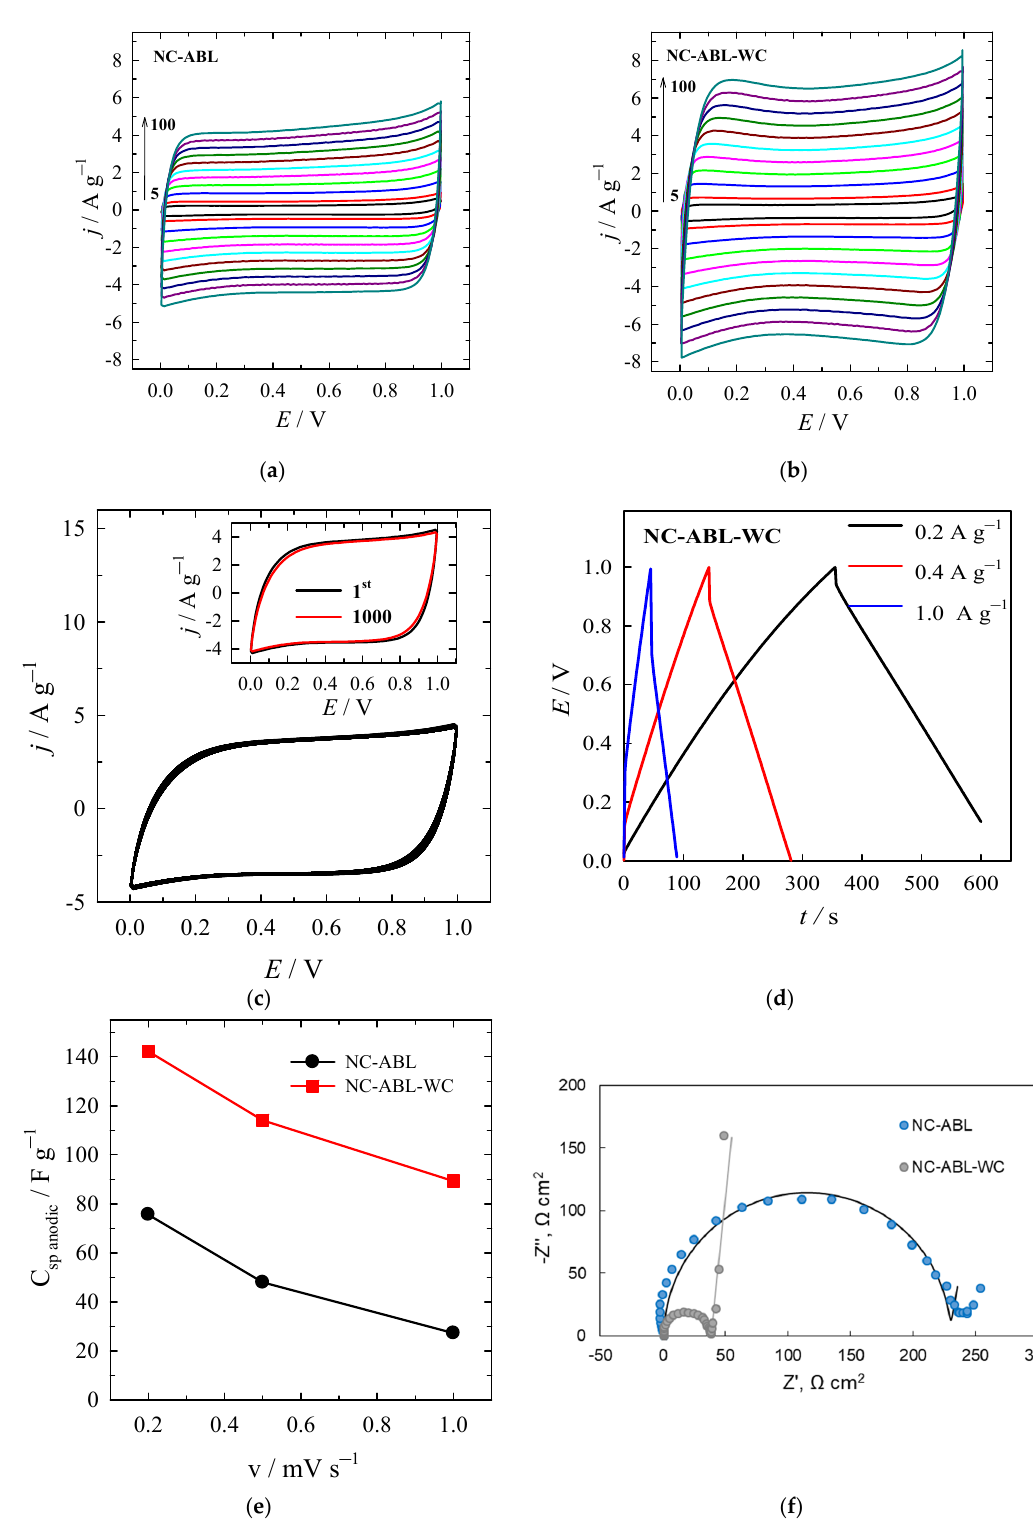
( f ) Figure 6. XPS spectra of NC-ABL ( a – c ) and NC-ABL-WC ( d , e ) carbons of C 1s ( a , d ), N 1s ( b , e ), and O 1s ( c , f ). The high-resolution C 1s XPS spectra of NC-ABL and NC-ABL-WC carbon samples are divided into four peaks at 284.3–284.4 (Csp 2 , 15.88–16.36 at%), 284.7–284.8 (Csp 3 , 51.55–40.00 at%), 285.4–285.3 (N-sp 2 -C, 22.44–36.49 at%), and 286.4–286.5 (N-sp 3 -C, 10.13– 7.15 at%) eV [48–50]. The N 1s peaks show four peaks identified as pyridinic-N (398.4– 398.6 eV, 38.87–36.83 at%), pyrrolic-N (399.3–400.2 eV, 24.03–28.40 at%), graphitic-N (401.0–401.2 eV, 28.78–24.62 at%), and oxidized-N (402.6–402.4 eV, 8.32–10.15 at%). The overall nitrogen content of the NC-ABL and NC-ABL-WC carbon samples was 4.33 and 3.34 at%, respectively, but most was in the pyridinic-N form, which is widely recognized as an ORR-active species [51,52]. The O 1s spectra can be deconvoluted into three peaks at 530.4–531.0, 531.9–532.2, and 533.3–533.6 eV corresponding to C=O, C-OH phenolic hy- droxyl/C-O-C ether, and COOH [53,54]. Oxygen functional groups greatly enhance the specific capacitance by introducing Faraday pseudo-capacitance [54]. Figure 7 presents the electrochemical performance of the NC-ABL and NC-ABL-WC samples using CV at scan rates from 5 to 100 mV s − 1 . Both samples exhibit a rectangular shape, indicative that the specific capacitance is mainly induced by the electrical double layer capacitance (EDLC) and partly by the Faraday pseudo-capacitance (PS) (Figure 7a,b). The long-term stability of the NC-ABL sample was also evaluated by recording CVs at 100 mV s − 1 for up to 1000 cycles (Figure 7c). The inset represents CVs after 1st and 1000 cycles. The specific capacitance retention was 99% after 1000 cycles, indicating good long- term electrochemical stability of the electrode.